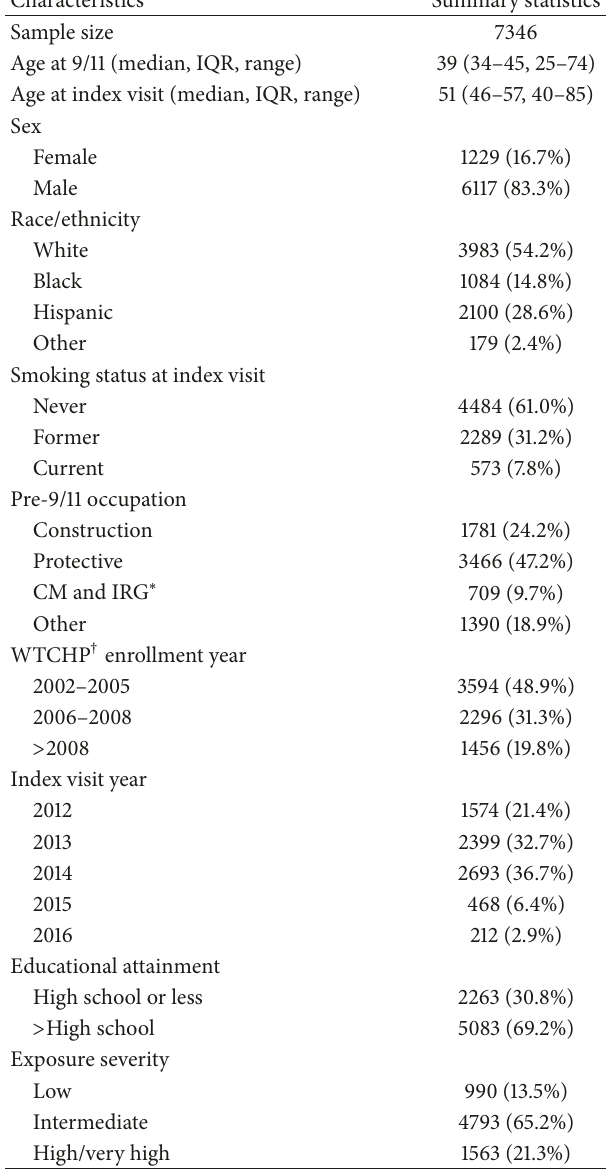
Table 2: Summary of demographic and exposure characteristics of the study sample.